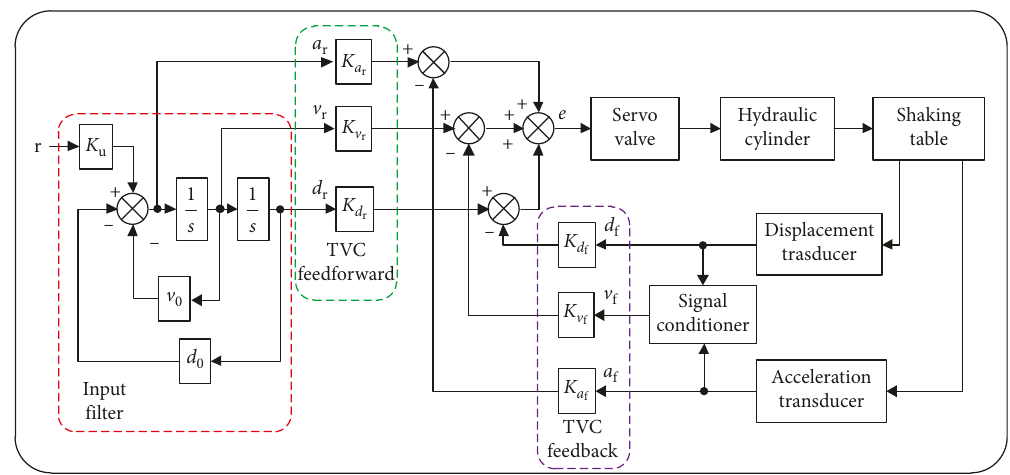
Figure 2: Control strategy of the hydraulic servo shaking